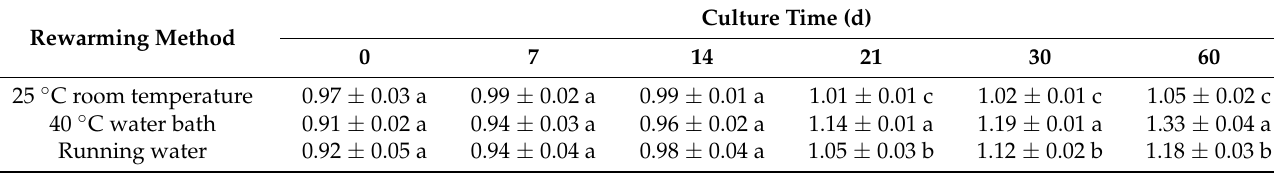
Table 5. Effects of rewarming methods on the fresh weight of F. mandshurica EC after cryopreservation by vitrification.